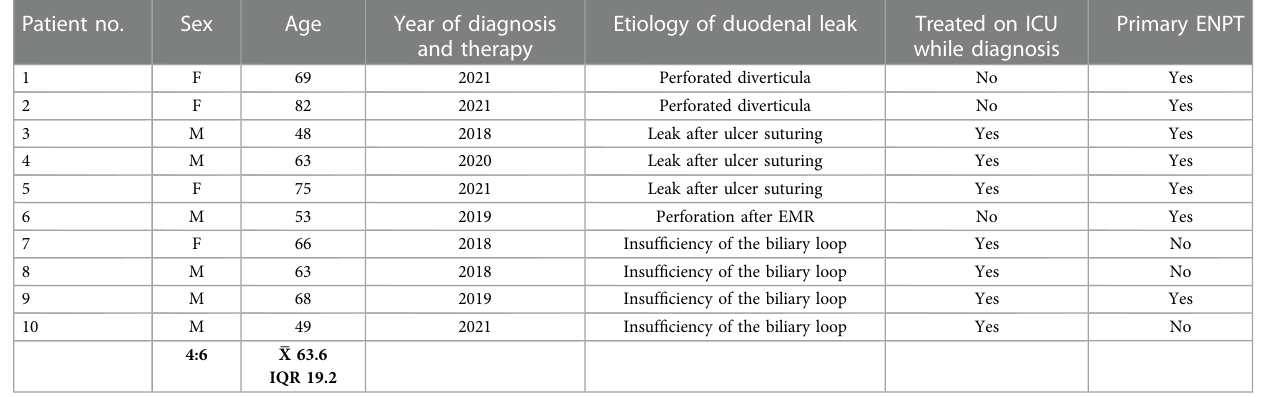
TABLE 1 Patients ’ characteristics. Patient